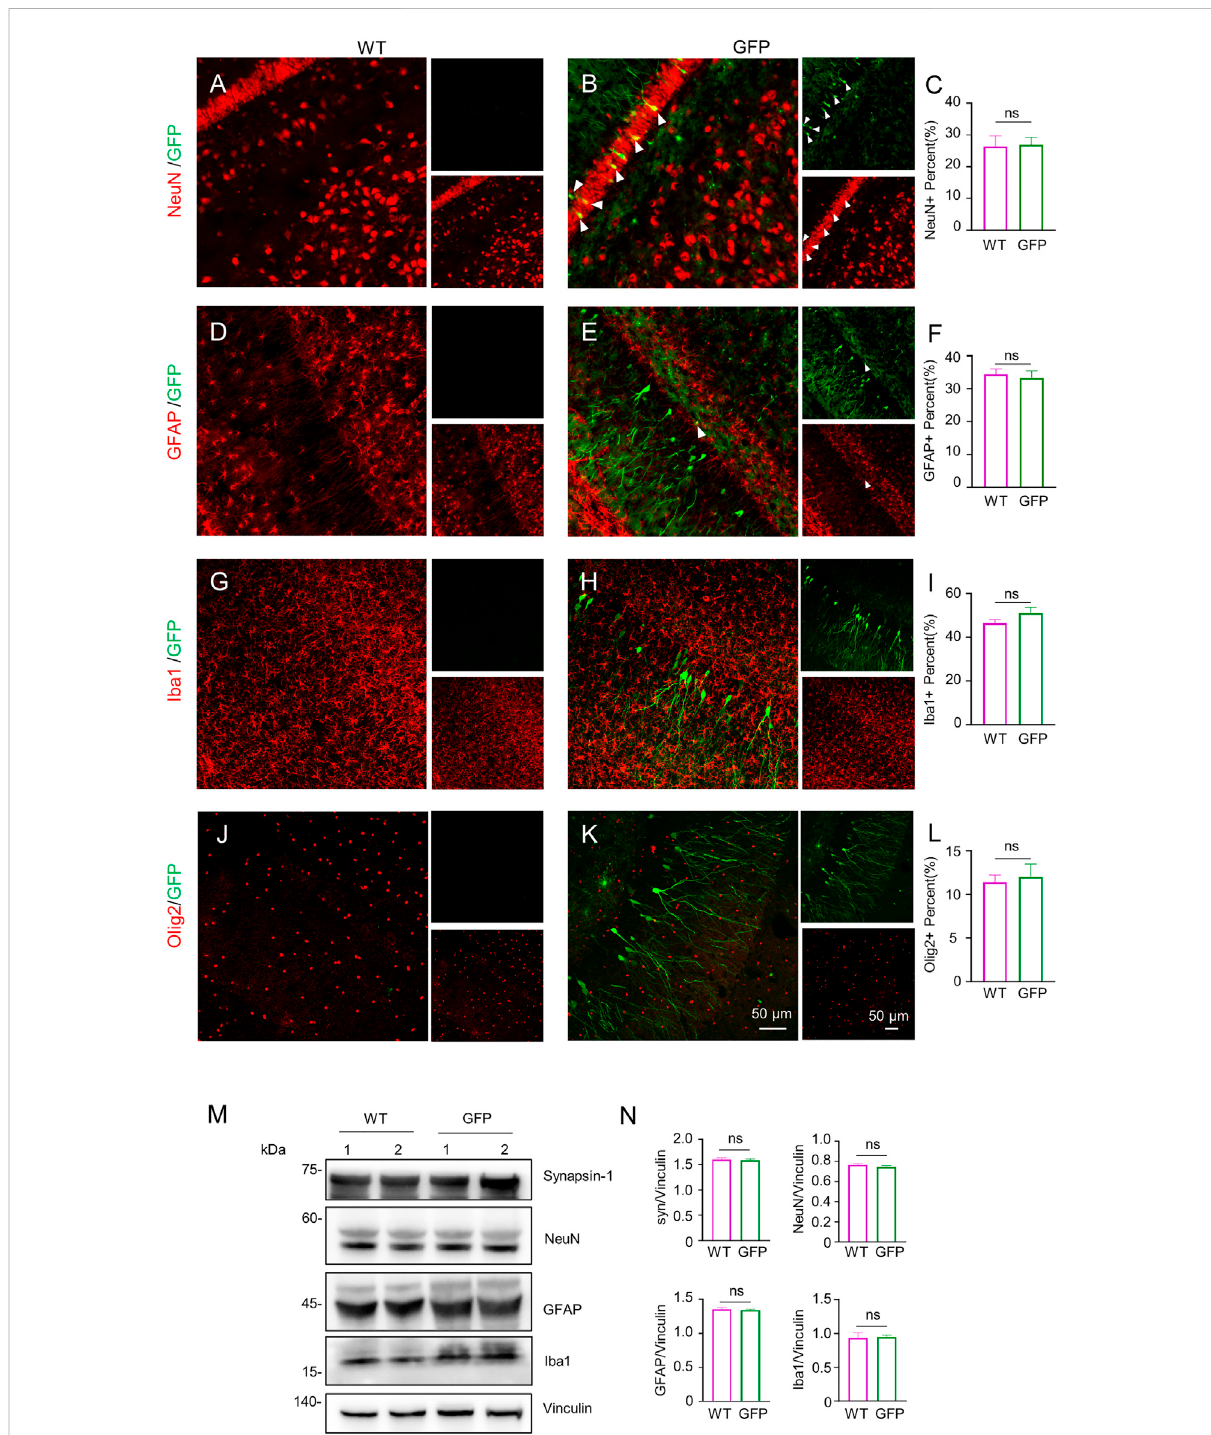
FIGURE 4 Immuno fl uorescent staining of the pigs ’ hippocampus injected with AAV-GFP or saline. (A – L) Double immuno fl uorescent labeling and quanti fi cation of neurons (NeuN) (A – C) , astrocytes (GFAP) (D – F) , microglial (Iba1) (G – I) and oligodendrocytes (Olig2) (J – L) of saline- or AAV-GFP- injected-wild type pigs. GFP positive cells are shown in green, NeuN, GFAP, Iba1 and Olig2 positive cells are shown in red. Data are analyzed by Student ’ s T-test and presented as mean ± SEM. n = 3 animals per group. (M) Western blotting of the hippocampus of saline- or AAV-GFP- injectedpigswithantibodiesagainstsynapsin-1,NeuN,GFAPandIba1.Vinculinservedasaloadingcontrol. (N) Quantitationoftheratiosofsynapsin- 1,NeuN,GFAP orIba1 to vinculin on thewestern blots. Data are analyzed bystudent ’ sT-test and presented as mean ± SEM. n = 3 animals per